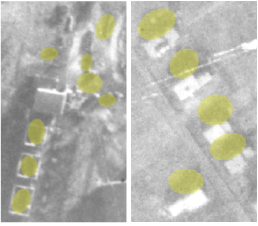
Figure 5: Objects that appear in a way that is similar to bomb craters in the image (e.g. houses or shadows of trees and houses) lead to numerous false